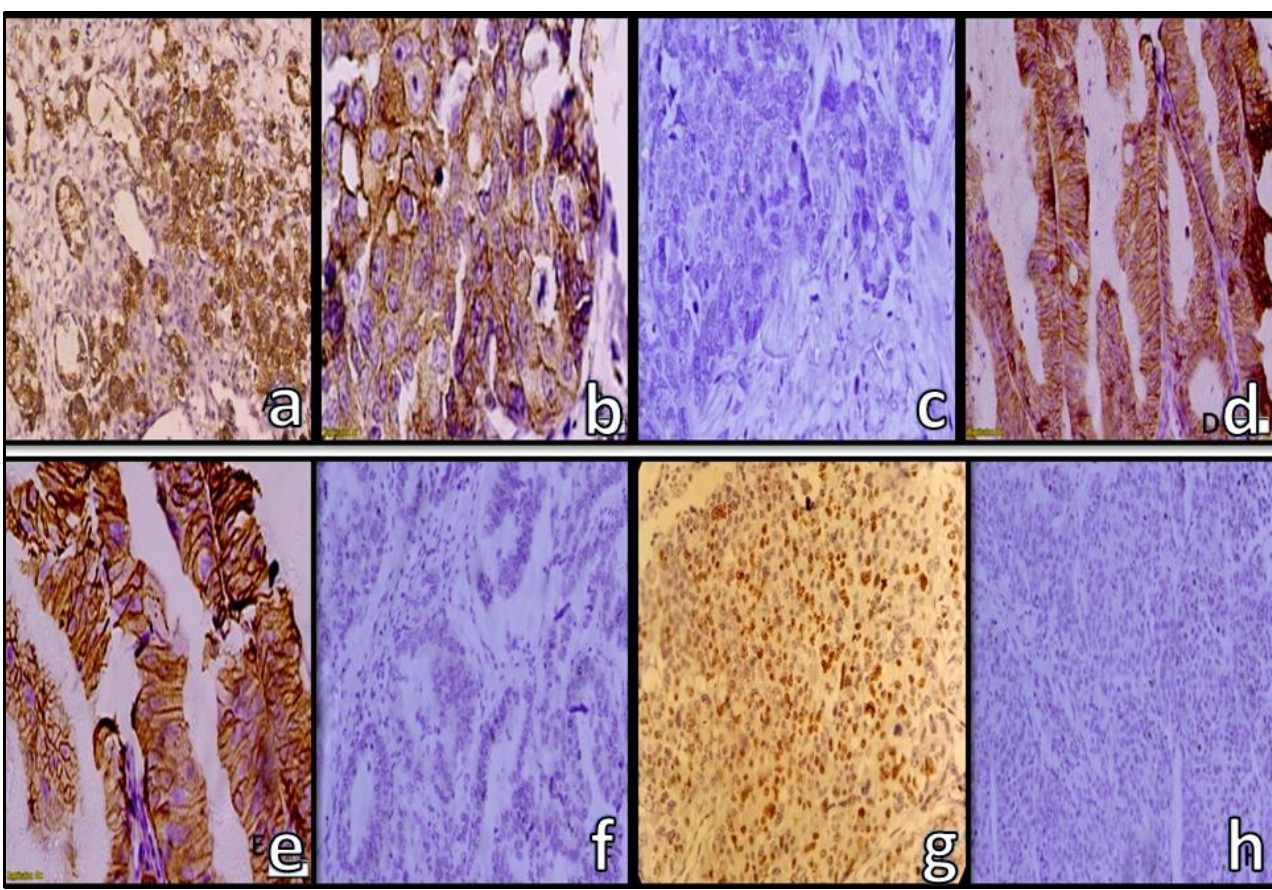
Figure 1: Immunohistochemical staining of EGFR, HER2& Ki67 in different cases of ovarian high-grade serous carcinoma [a) High EGFR expression showing positive cytoplasmic staining, FSS=12, X100; b) High EGFR expression showing positive membranous staining, FSS=12, X400; c) Low EGFR expression showing negative staining, FSS=0, X200; d) High HER2 expression showing positive complete membranous staining in >10% of tumor cells, score +3, X100; e) High HER2 expression showing positive complete membranous staining in >10% of tumor cells, score +3, X200; f) Low HER2 expression showing negative staining, x100); g) High K-i67 proliferative marker, X200, h) Low